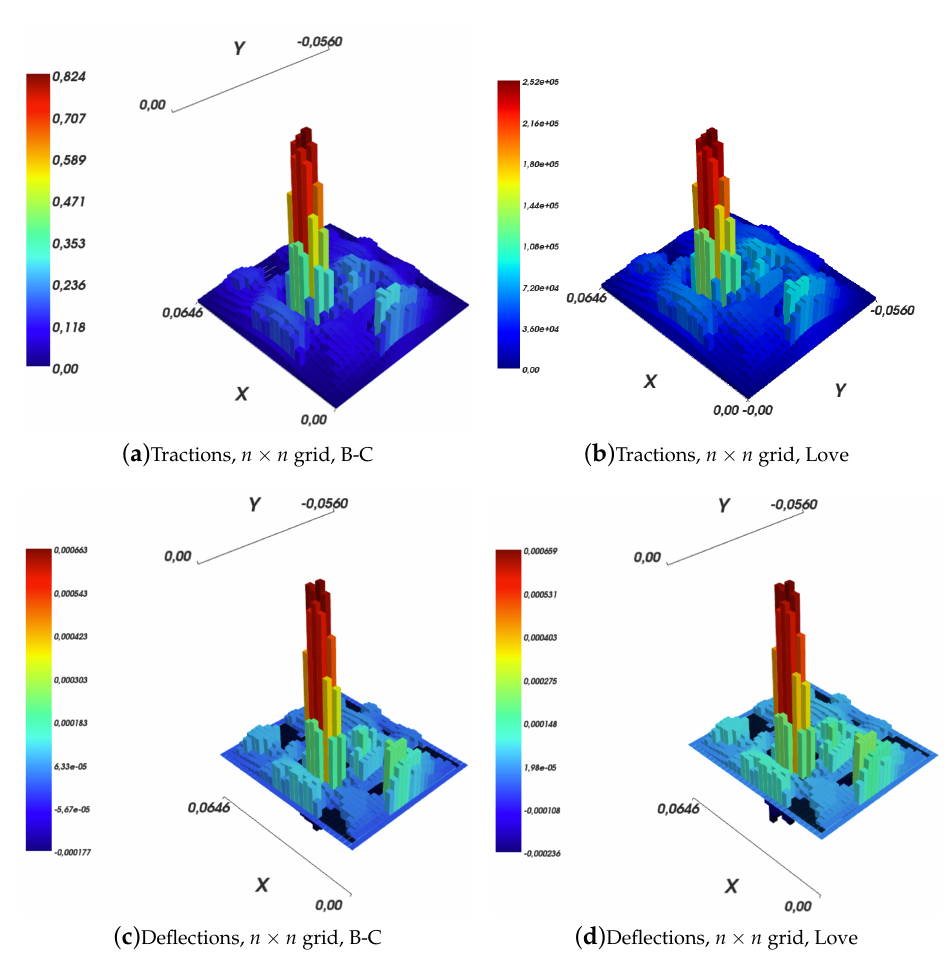
Figure 15. Influence of non-negativity constraints on traction and deflection reconstructions for Boussinesq–Cerruti’s and Love’s